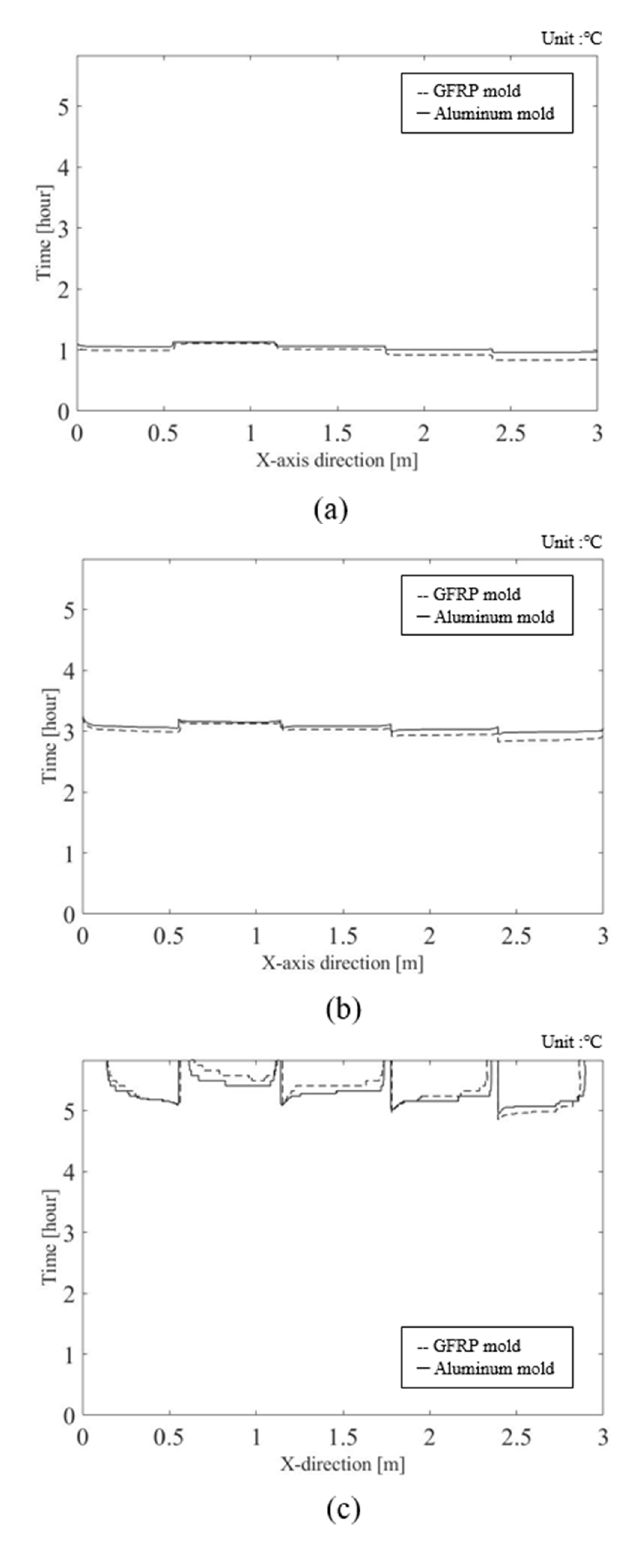
Figure 10. Top surface temperature of spar-cap on transient state analysis (case 7 at reference models): ( a ) 40 °C; ( b ) 60 °C; ( c ) 80 °C.